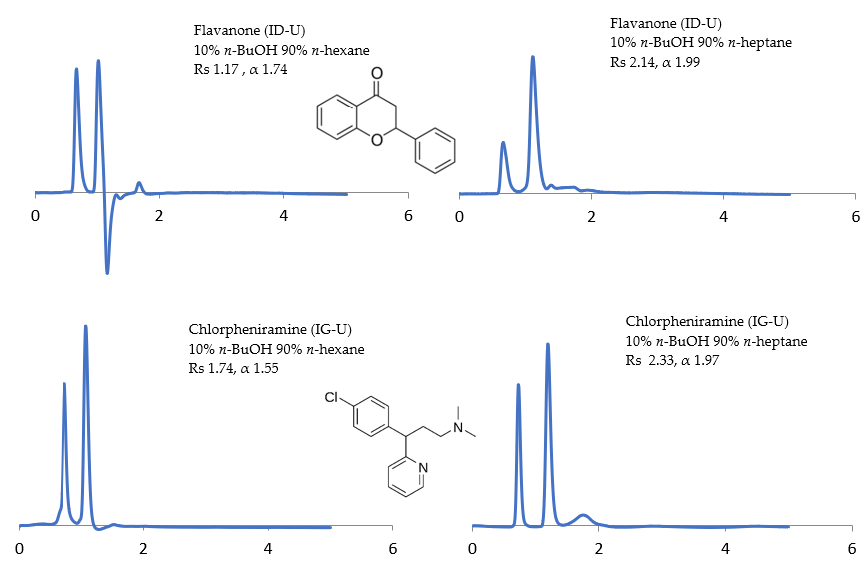
Figure 2. Effect of n -hexane versus n- heptane on resolution (Rs) and separation factor ( α ) using Chiralpak ® IG-U and ID-U.